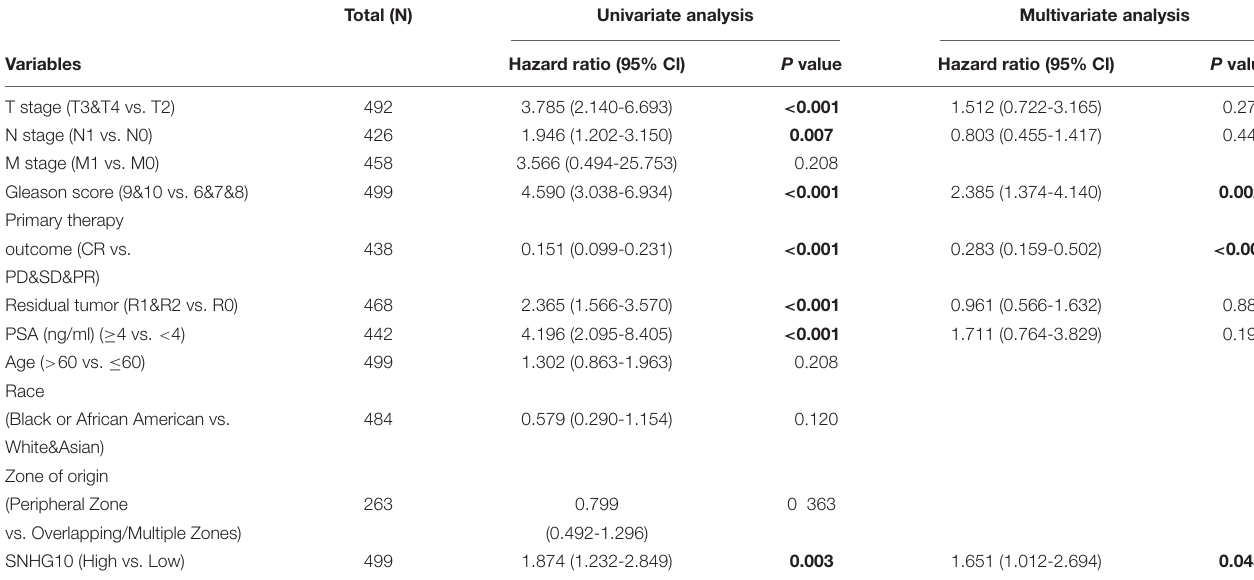
TABLE 2 | Univariate and multivariate regression analyses of PC. Total (N) Univariate analysis Multivariate